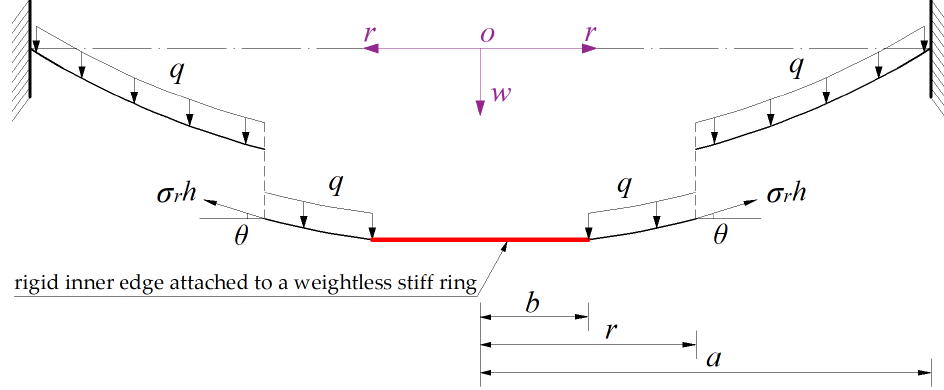
Figure 3. Sketch of the free body with radius r ( b ≤ r ≤ a ).